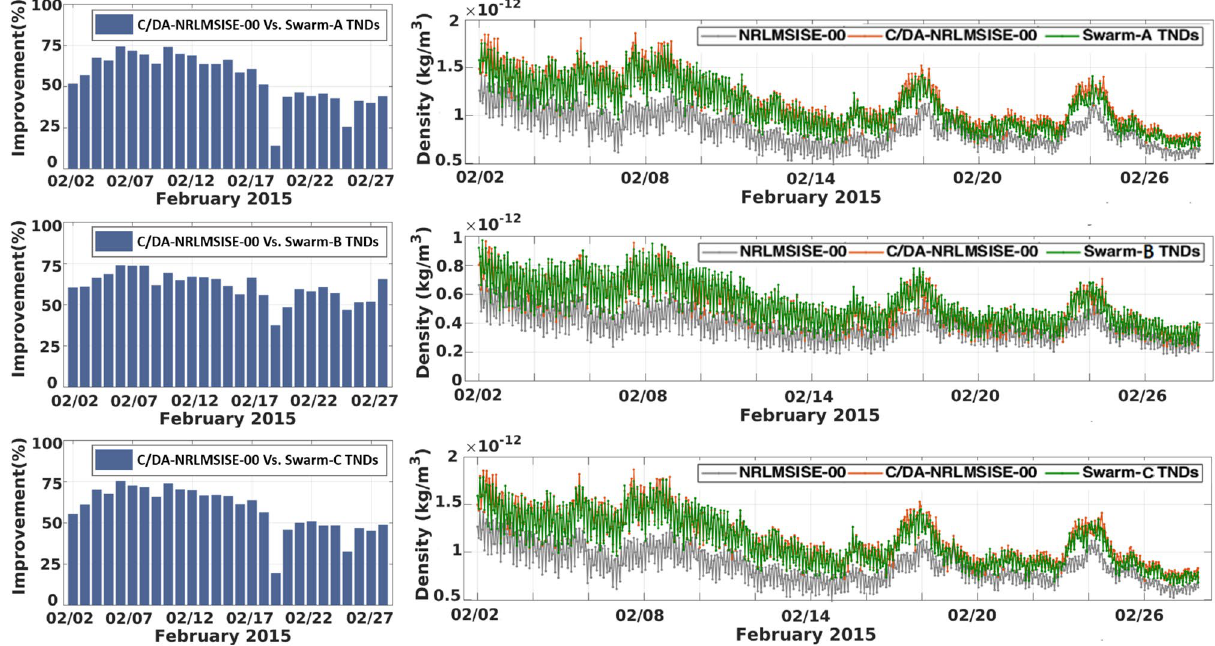
Figure 4. A comparison of the estimated improvements (Eq. (6)) and the time series of TNDs derived from the original NRLMSISE-00 and C/DA-NRLMSISE-00 models along with Swarm TNDs during February 2015. The C/DA is processed using GRACE-TNDs as observations, then the C/DA-NRLMSISE-00 densities are evaluated along the Swarm-A, -B and -C orbits. The plots were made in MATLAB (version R2021a, https:// www. mathw orks. com/).